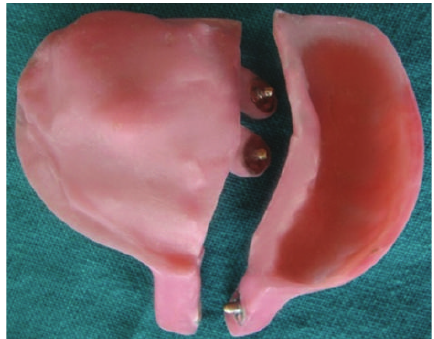
Figure 12: Dissembled impression.